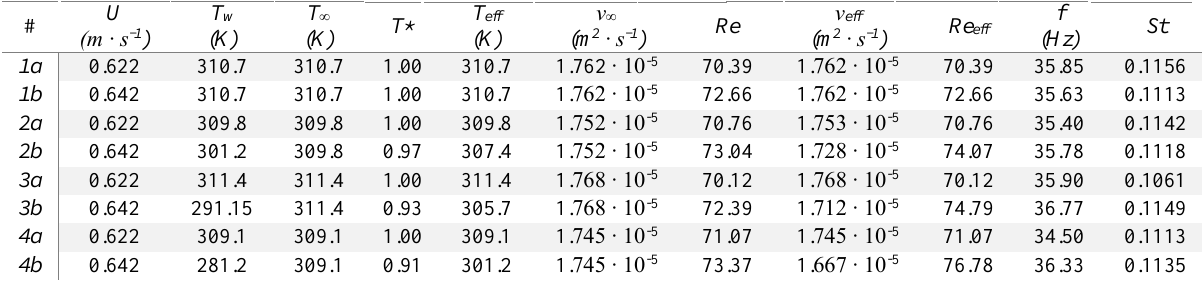
Tab. 1. Results from the visualization measurement; a – upper cooled cylinder, b – reference isothermal cylinder.